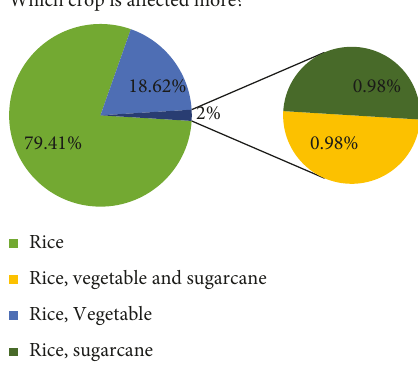
Figure 5: Status of crops affected in the study